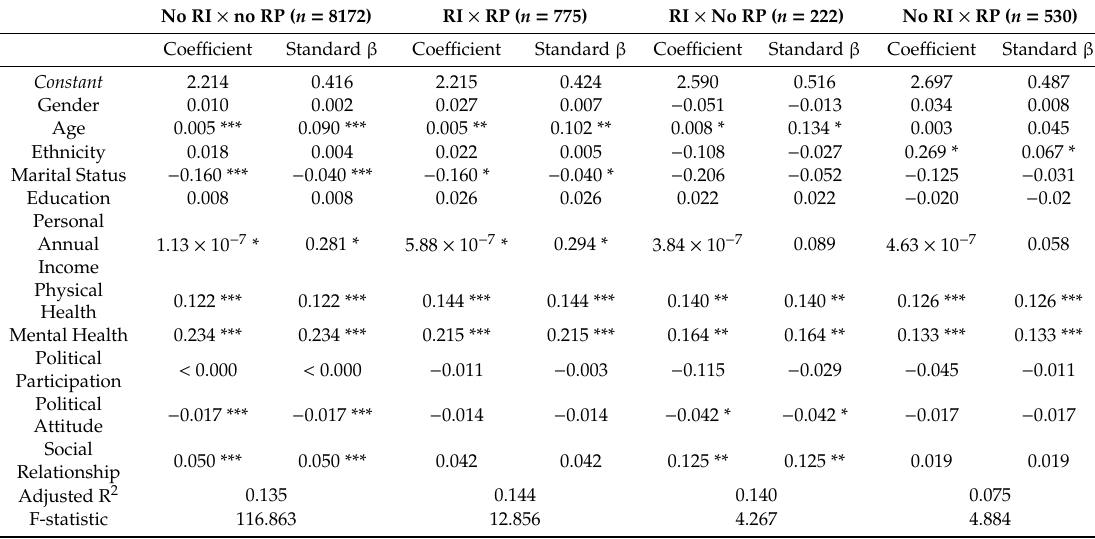
Table 2. Regression results of four religion moderating